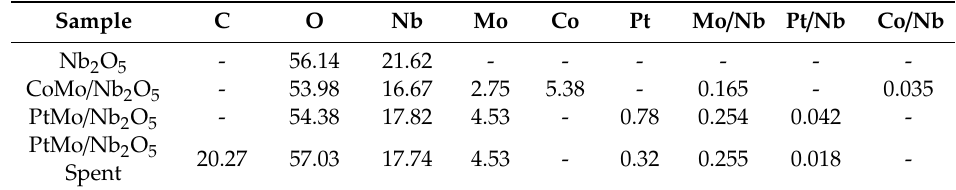
Table 3. Surface chemical composition in atomic concentration (%) of the studied catalysts determined by